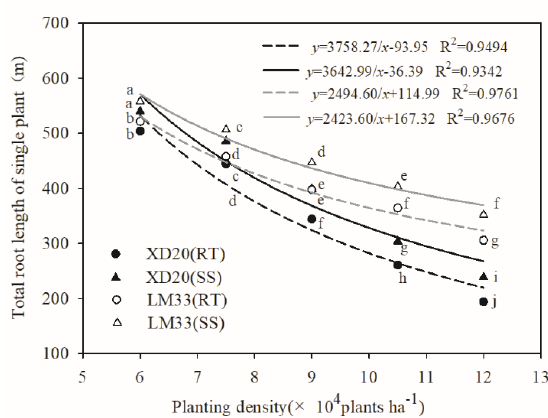
Figure 1. Root dry weight of high-yielding spring maize under different tillage methods and planting densities. Different letters on the graph indicate significant differences at p < 0.05.